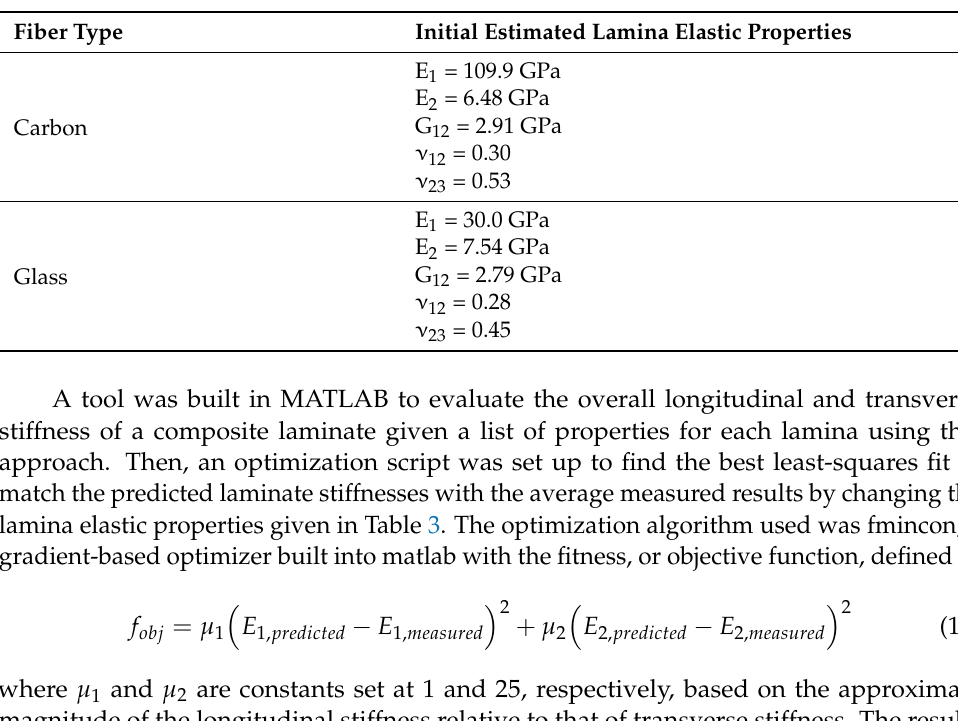
Table 3. Elastic properties of carbon and glass lamina estimated from finite element RVE model and constituent properties from the literature in Table